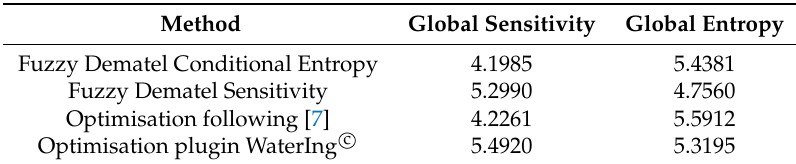
Table 5. Comparison table for the four considered